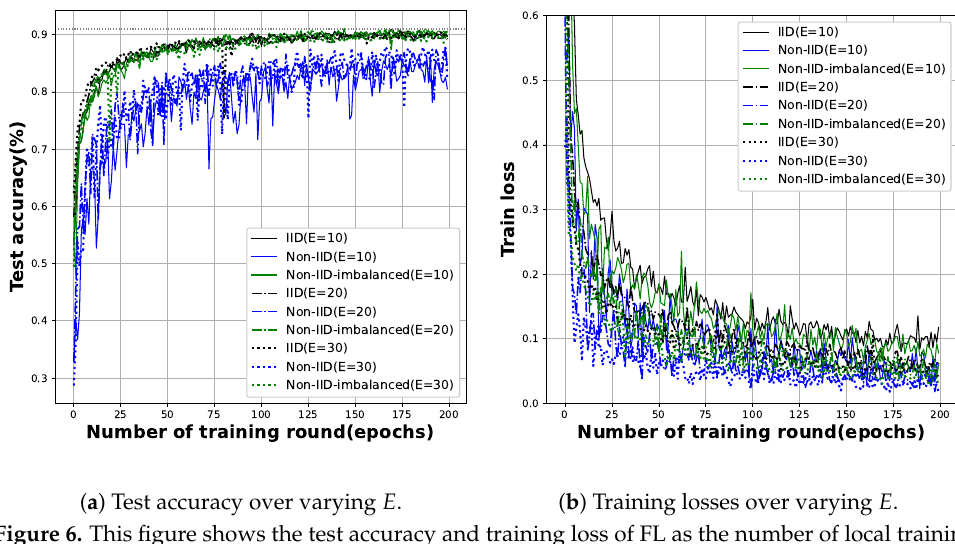
Figure 6. This figure shows the test accuracy and training loss of FL as the number of local training rounds ( E ) varies under three different data